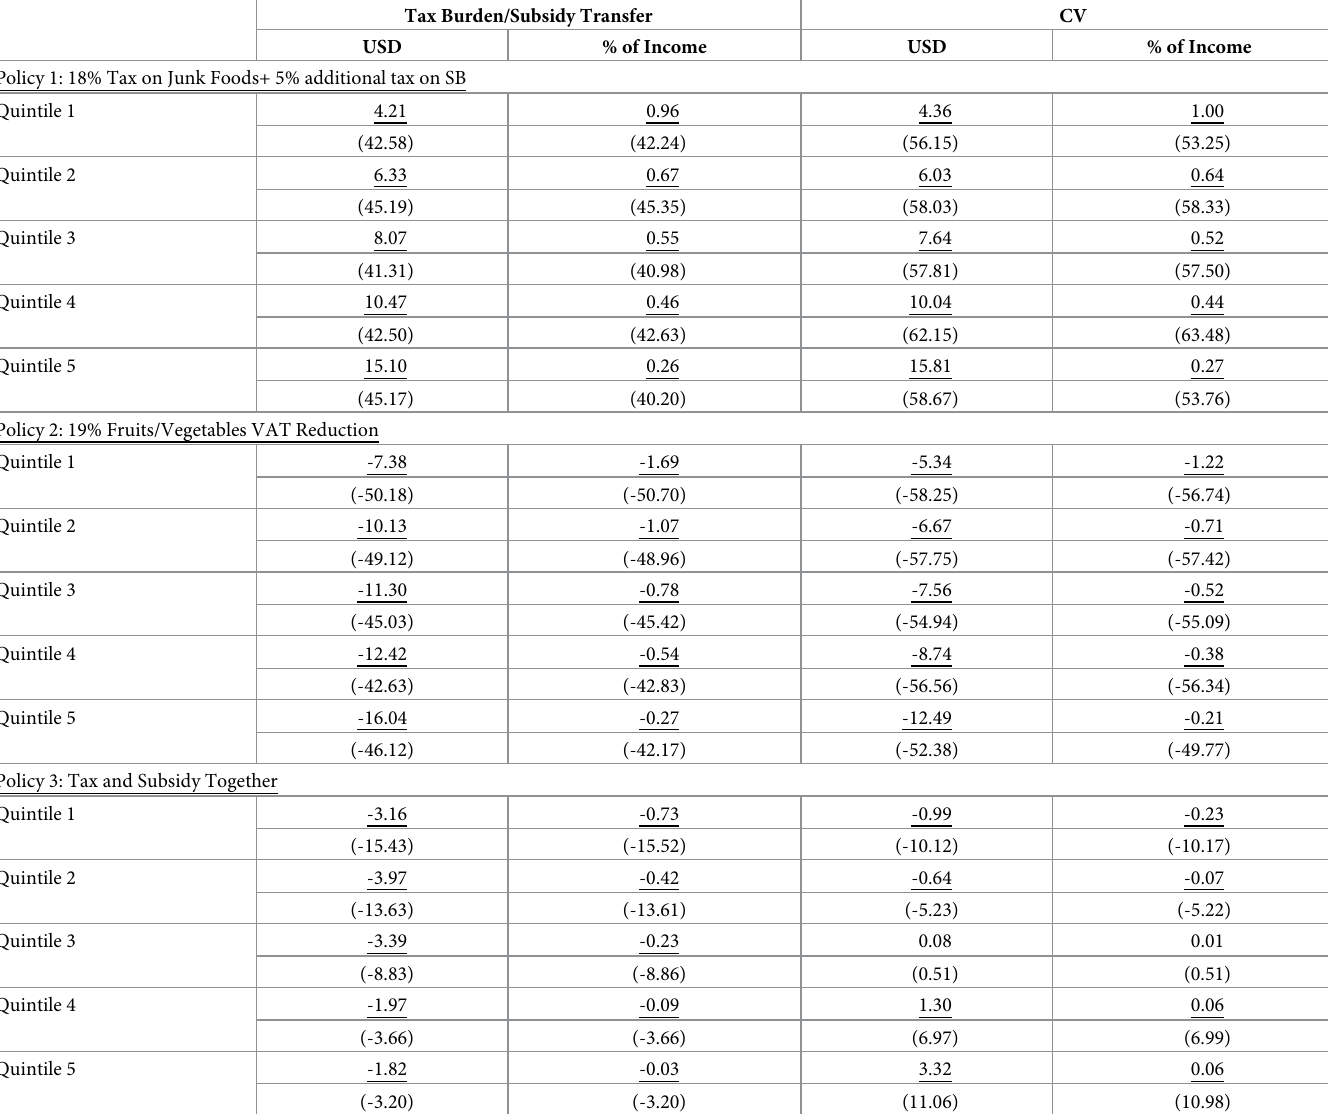
Table 6. Estimated Compensating Variation (CV) and tax burden/subsidy transfer assuming a 100% pass-through of taxes/subsidies in prices, all